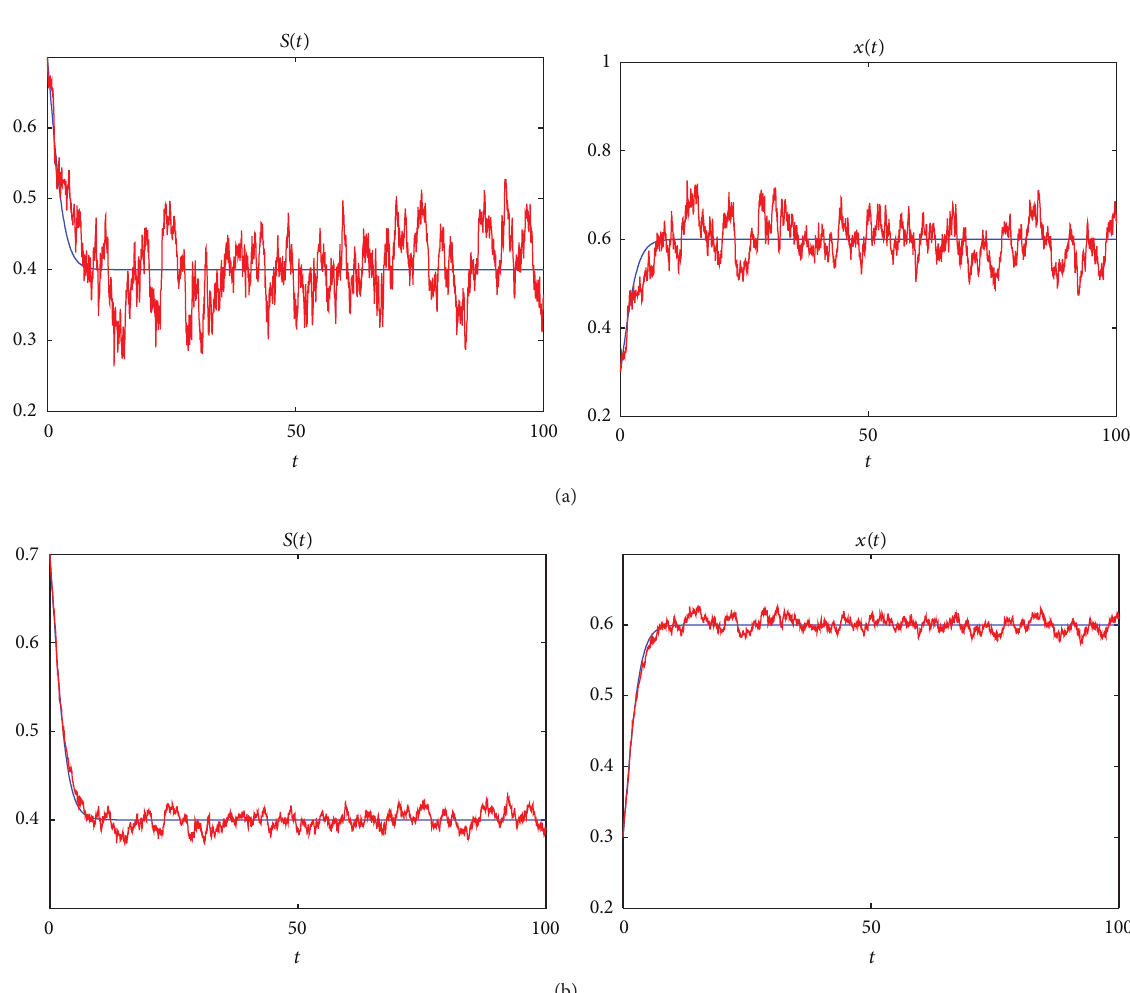
Figure 2: Deterministic and stochastic trajectories of simple chemostat model for initial condition 𝑆 0 = 0.7 ; 𝑥 0 = 0.3 ; and 𝑆 0 = 1 , 𝑚 = 2 , 𝑎 = 0.6 , and 𝐷 = 0.8 . (a) 𝛼 = 0.1 , (b) 𝛼 = 0.02